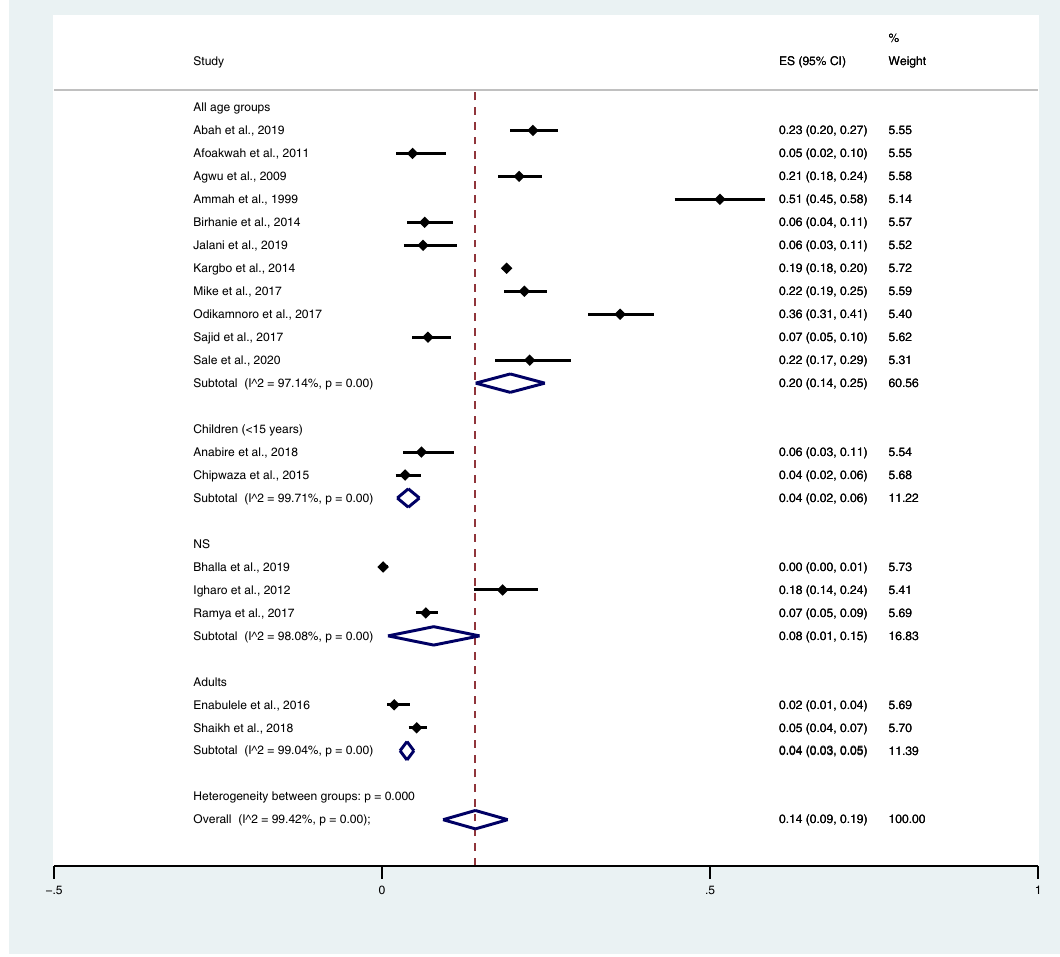
Comparison of typhoidal/NTS infections among patients with severe and non‑severe malaria. The pooled prevalence rates of typhoidal/NTS infections among patients with severe and non-severe malaria were estimated using data from 24 studies that enrolled patients with non-severe malaria 28,37,38,44,50,53,56–58,60,66,68,69,71,77,78,81,83,89,98,104–106,108 and 6 studies that enrolled patients with severe malaria 30,54,63,79,80,85 . All 30 studies employed the blood culture method to identify Salmonella spp. infections. The pooled prevalence rates of typhoidal/NTS infection were 2% in patients with severe malaria (95% CI 1–3%; I 2 , 91.5%) and 3% in patients with non-severe malaria (95% CI 2–3%; I 2 , 86.8%) (Fig. 21). Prevalence of malaria infections among patients with typhoidal/NTS infections. The pooled prevalence rate of malaria infections among patients with typhoidal Salmonella spp. infection was estimated from three studies 20,31,49 . The pooled prevalence rate of malaria infection in patients with typhoidal Salmonella